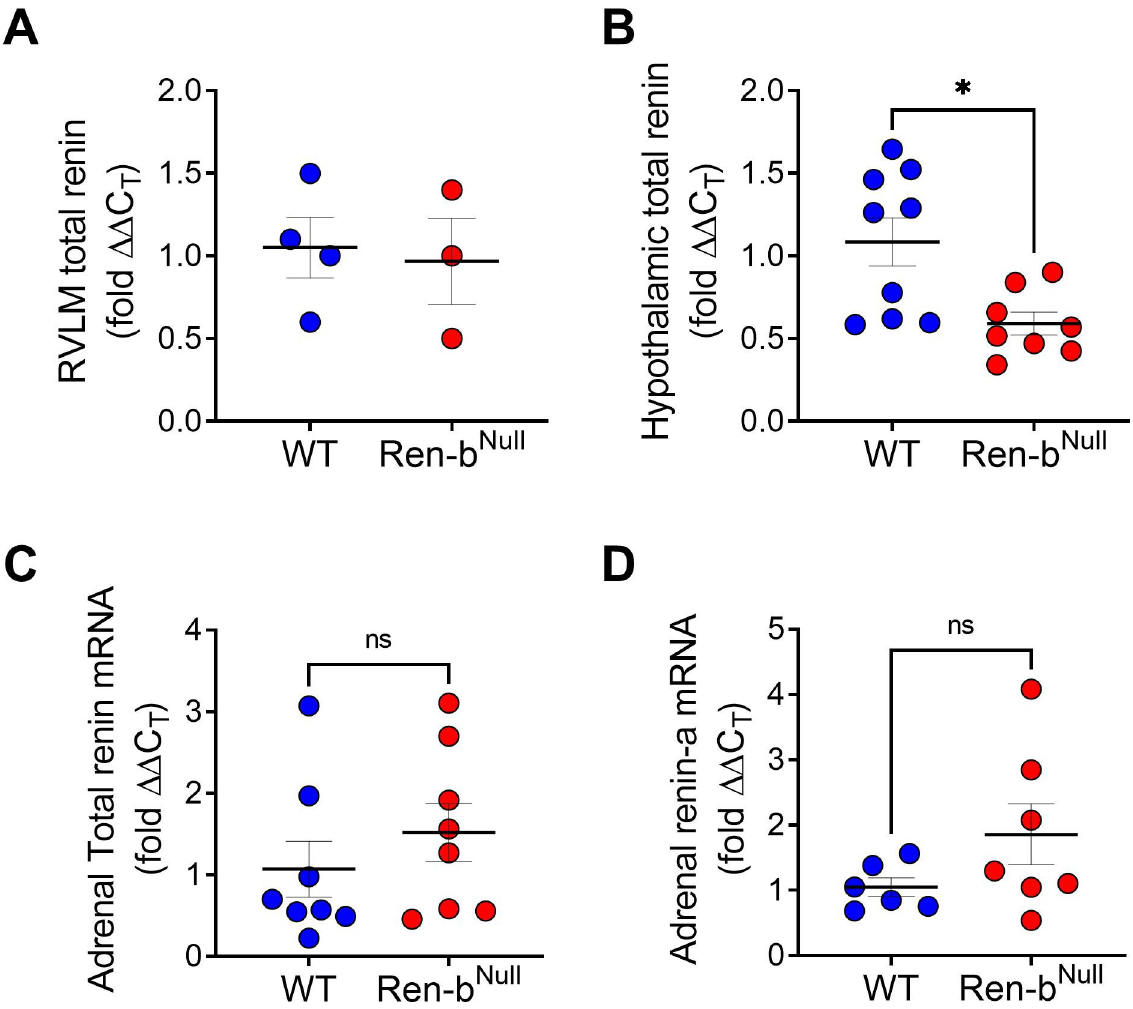
Fig 8. Using quantitative reverse transcription PCR total renin expression was measured in A) the rostral ventrolateral medulla (RVLM) and B) the whole hypothalamus. C and D) In the adrenal glands, total renin and renin-a were measured. The wildtype (WT) and Ren-b Null mice were fed a normal salt diet. The data were analyzed by unpaired t-test. � P < 0.05 vs